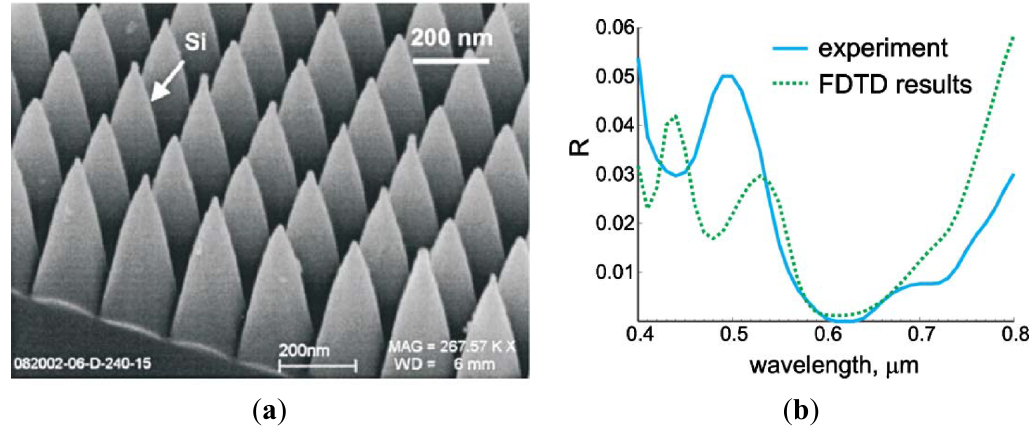
Figure 15. SEM image of square packed silicon cones ( a ) and ( b ) comparison of FDTD (dotted) and experimental results (solid). Reprinted with permission from reference [32], Copyright 2009 Optical Society of America.